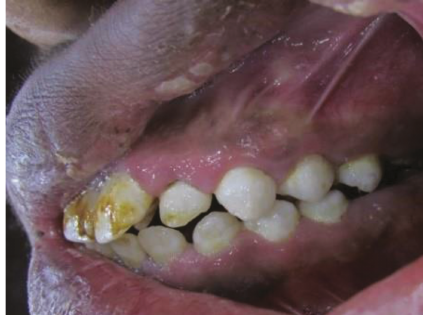
Figure 14: Case 3: small size of teeth which may be due to gingival enlargement or incomplete eruption (left side view).